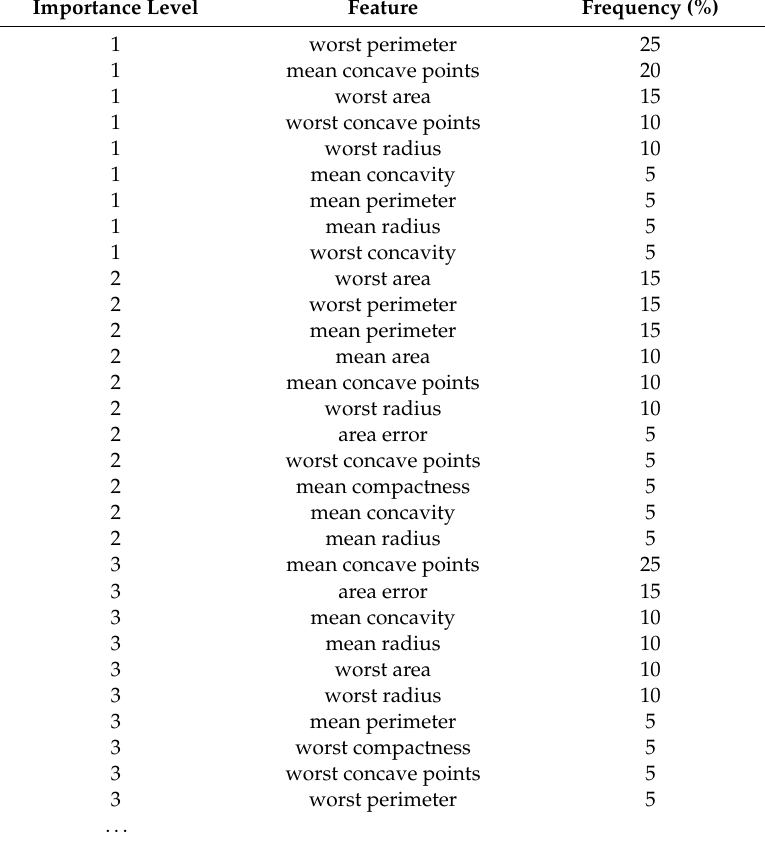
Table 4. The most frequent feature combinations by importance order—UCI-BCW dataset, 20 runs. For each importance level, the features that were placed to that level are listed with the percentages of their occurrence at that level among runs for the built-in